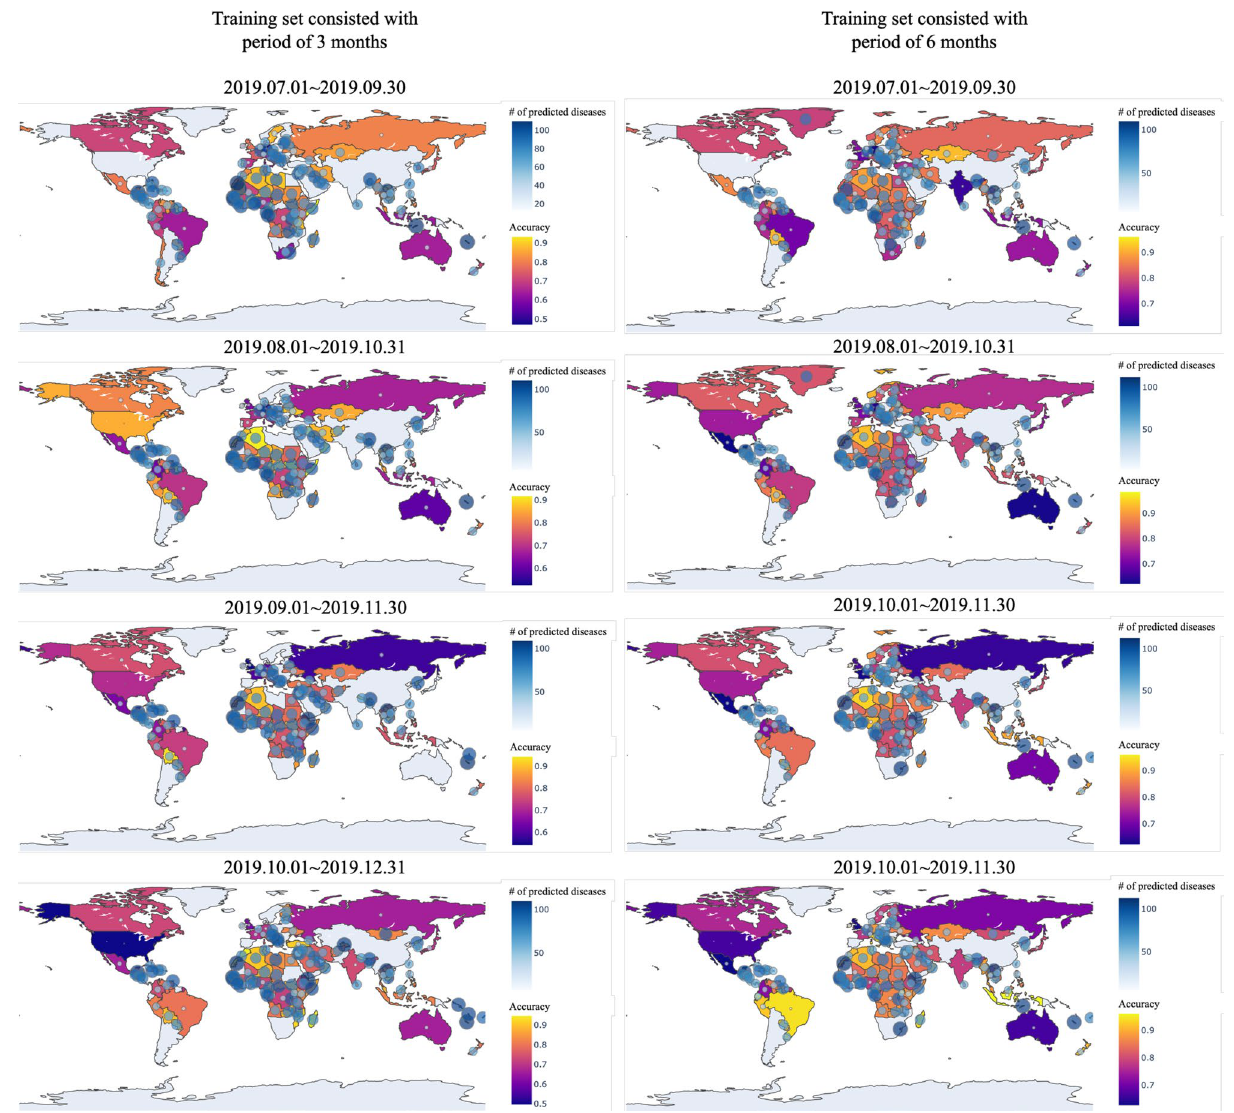
Figure 10. Prediction accuracy of SSL by each country: blue circles in the map indicate the number of predicted diseases for the country, and the closer the yellow, the more accurate the blue, the lower the accuracy. The figure was created in Python3 using the Basemap